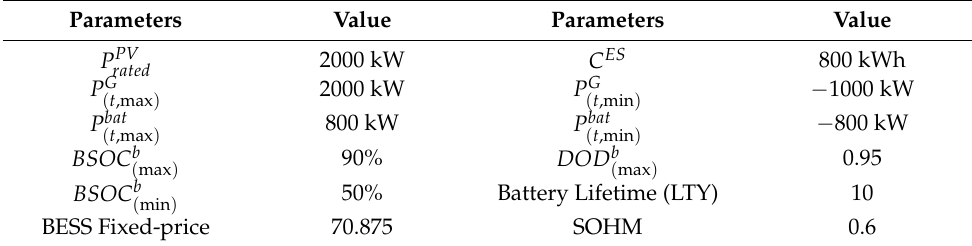
Table 1. Optimal Sizing System Parameters.